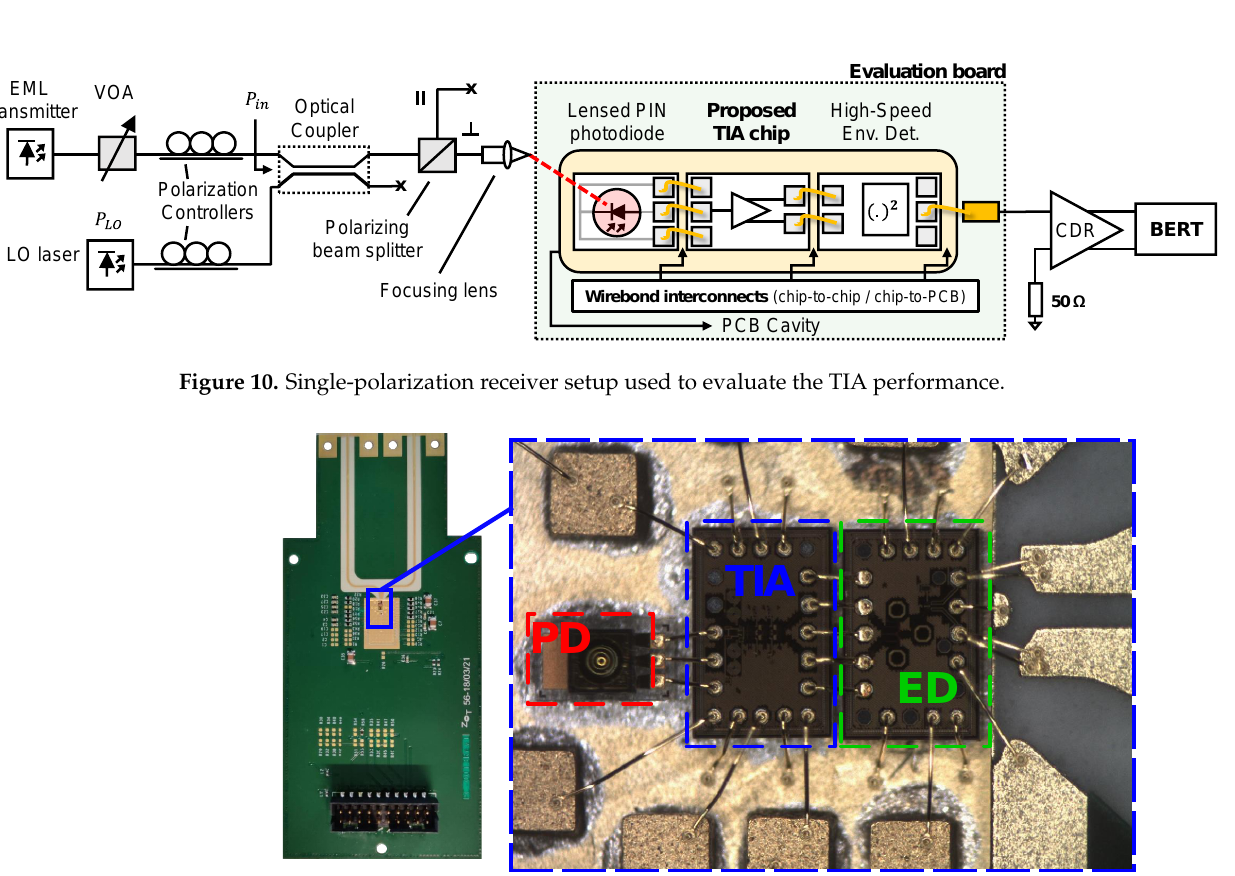
Figure 11. Evaluation board hosting the electrical receiver front-end (left) with magnified view of the die sub-mount consisting of a lensed PIN photodetector, the fabricated TIA chip, and a high-speed envelope detector. Both TIA and ED chips have been fabricated in the same